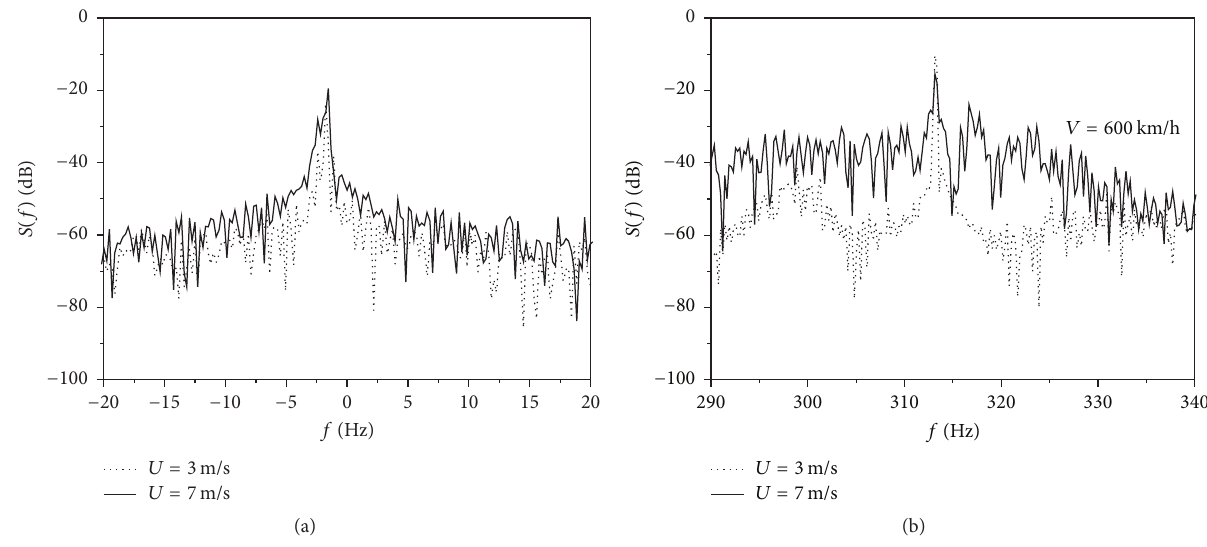
Figure 7: Doppler spectra at different wind speeds: (a) sea clutters, (b) target.